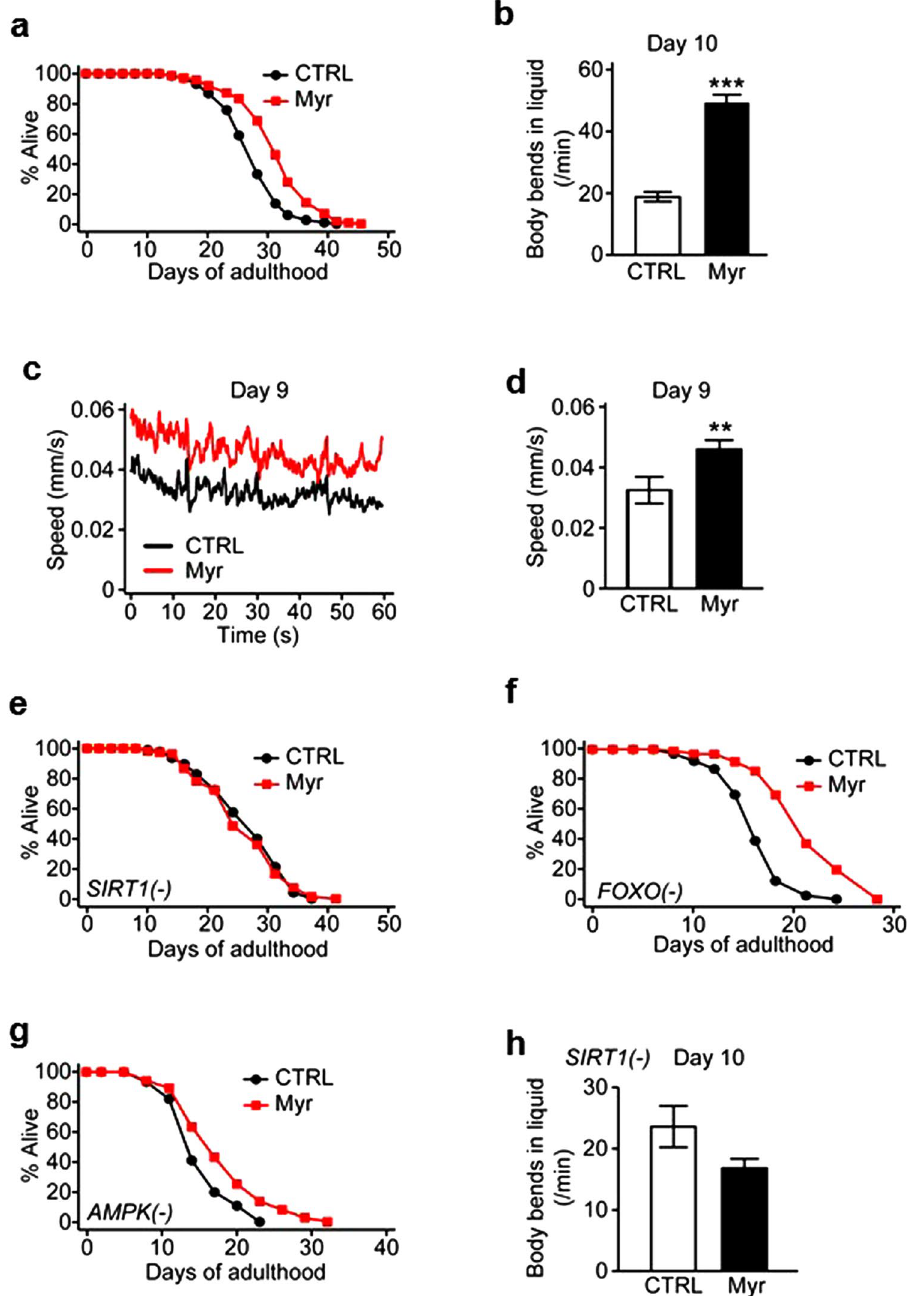
Figure 4. Myricetin improved locomotion and delayed aging in C. elegans via SIRT1. ( a ) Myricetin increased the lifespan of wild-type C. elegans . ( b ) Myricetin treatments increased the body bending rates of old (day 10 adult) wild-type C. elegans . ( c ) Enhanced motility of myricetin-treated worms measured by Multi-Worm Tracker at day 9 of adulthood. ( d ) Average speed of the worms measured for 1 min shown in panel B (n ≥ 11). ( e ) SIRT1/ sir-2.1(ok434) [SIRT1( − )] mutations suppressed the lifespan-extending effect of myricetin. ( f , g ) Myricetin extended the lifespan of FOXO/ daf-16(mu86) [FOXO( − )] mutants ( f ) and AMPK/ aak-2(ok524) [AMPK( − )] mutants ( g ). ( h ) Myricetin treatments did not increase the body bending rates of old (day 10 adult) SIRT1 mutants (n = 15). Error bars represent standard error of the mean (SEM) (two-tailed Student’s t-tests, ** p < 0.01). See Supplemental Table S2 for additional repeats and statistical